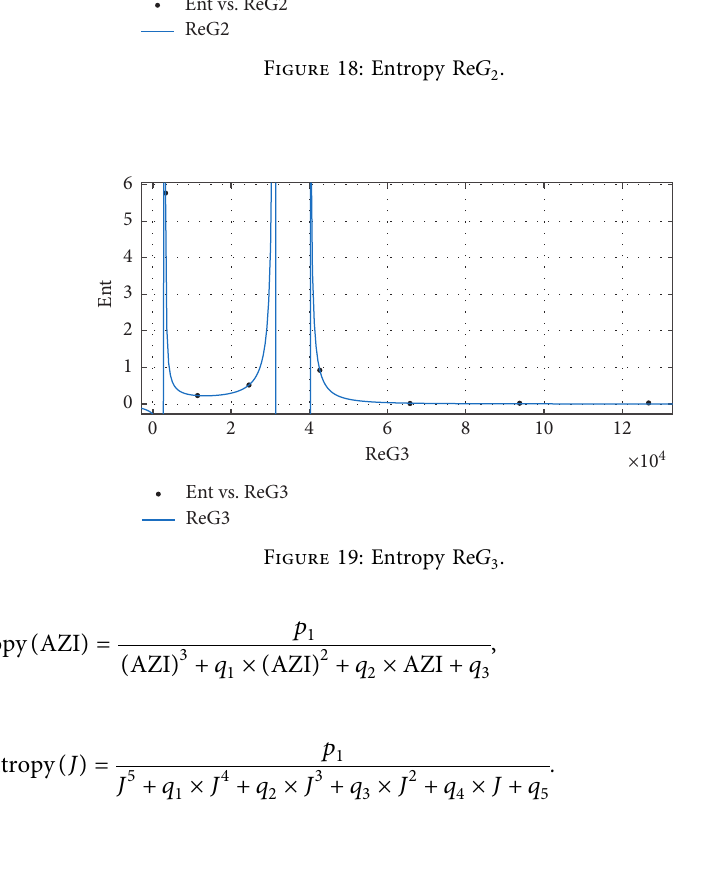
Figure 18: Entropy Re G